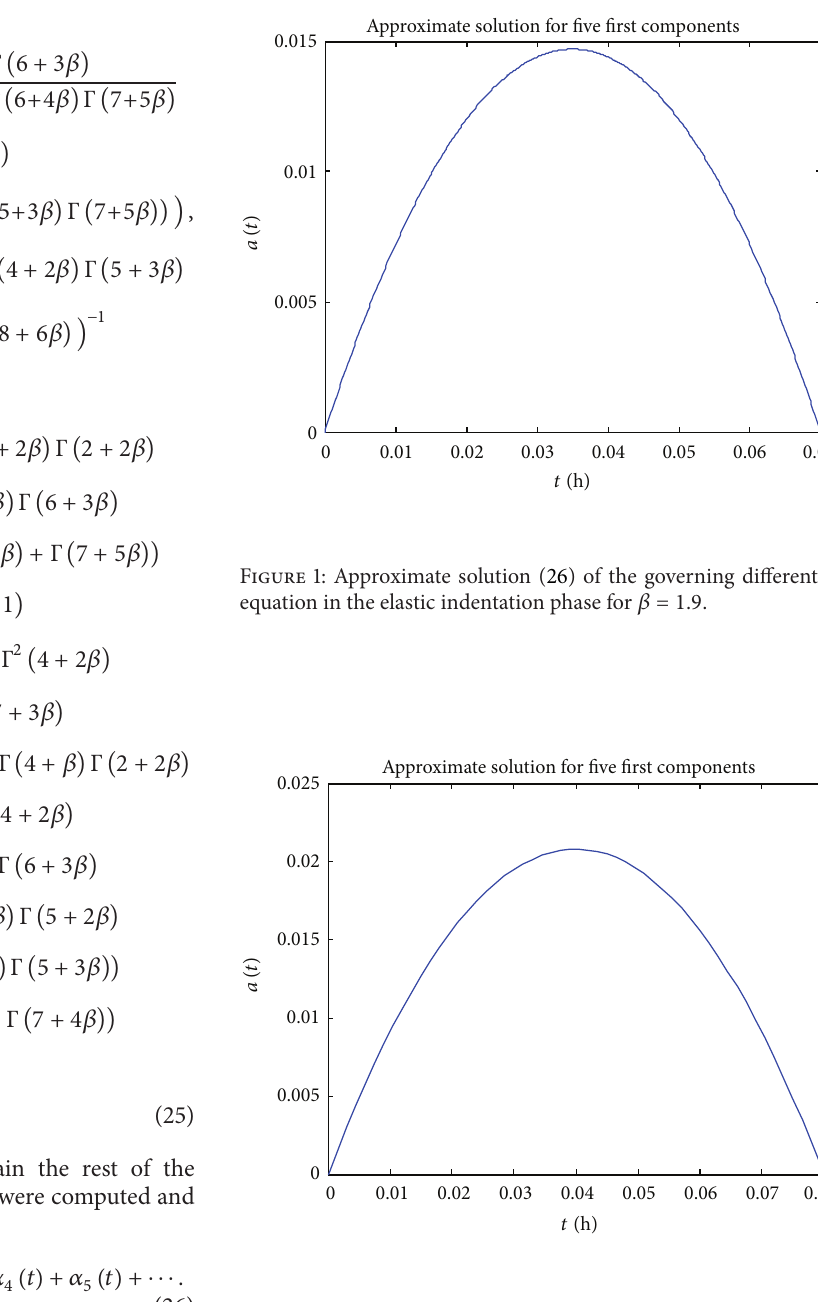
Figure 2: Approximate solution (26) of the governing differential equation in the elastic indentation phase for 𝛽 = 2